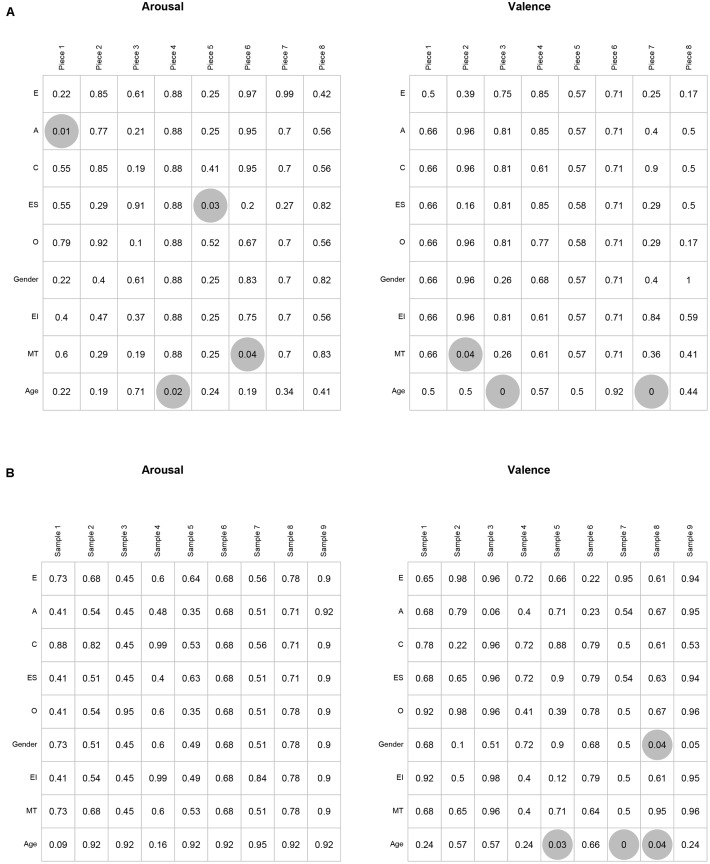
Results of functional ANOVAs on ratings of arousal and valence of music (A) and speech (B) according to personality (E, Extroversion; A, Agreeableness; C, Conscientiousness; ES, Emotional Stability; O, Openness to new experiences), gender, emotional intelligence (EI), musical training (MT), and age. Gray circles represent significance at p < 0.05, with BH correction applied.